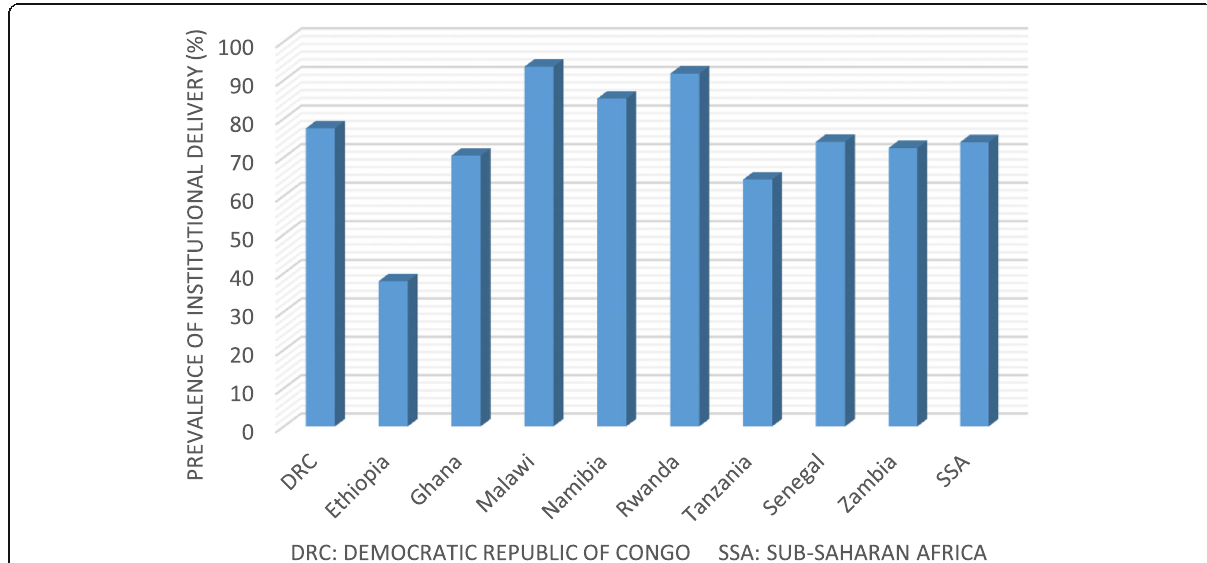
Fig. 1 The prevalence of institutional delivery in the nine Sub-Saharan Africa countries from 2013 to 2017. DRC: Democratic Republic of